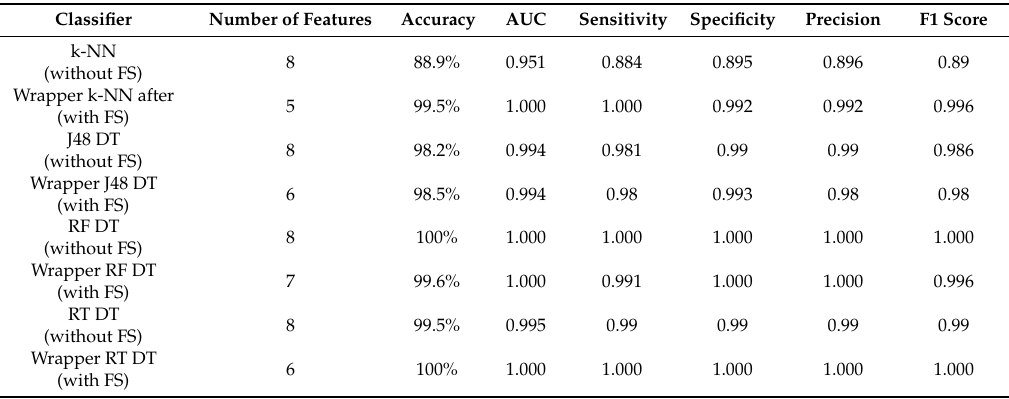
Table 3. The classification results before and after the feature selection results using best first (stepwise forward and backward search strategy) for the MIAS dataset.